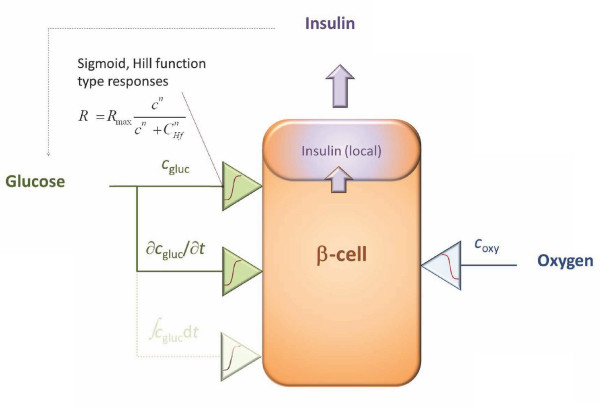
Schematic concept of the present model of glucose-stimulated insulin release in β-cells. It is implemented within a general framework of sigmoid proportional-integral-derivative (SPID) controller, and responds to glucose concentrations, but is also influenced by the local availability of oxygen. A total of four concentrations are modeled for 'local' and released insulin (cinsL, cins), glucose (cgluc), and oxygen (coxy), respectively.